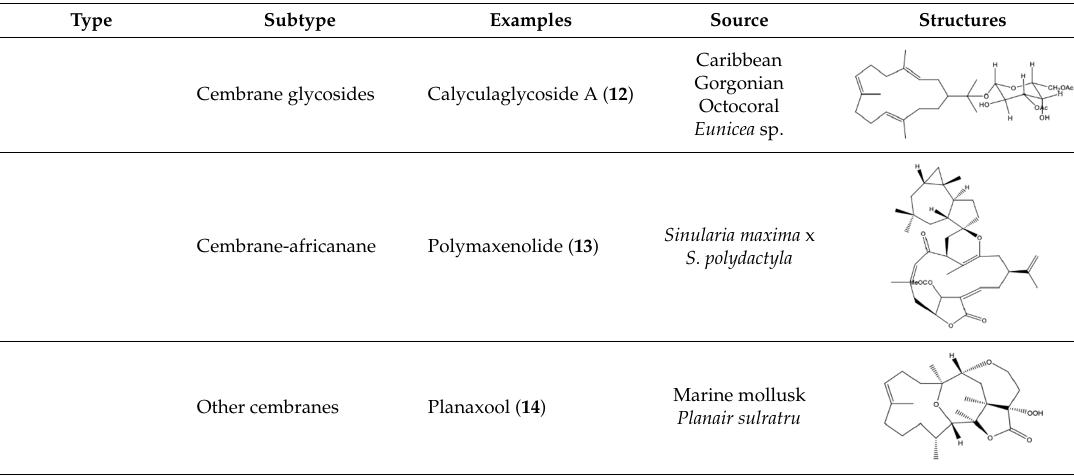
FTIR (Fourier-transform infrared spectrosocopy), single crystal X-ray diffraction, and LC-MS-IT-TOF (liquid chromatography–mass spectrometry-ion trap-time-of-flight) [9,20–57]. The review upon the source, chemistry and bioactivities of new cembrane diterpenes from marine organisms, since 2016 (27 works) (Tables 2–4) revealed that the most important sources of cembrane derivatives found in that period were coming from the genus Sarcophyton (14 works), Sinalarina (8 works) and Lobophytum (5 works). There is still one work in which the authors did not isolate new cembrane compounds but they checked the biological properties of the crude methanolic extract of Lobophytum crassum from the coast of Madagascar [24]. In other work, Al-Footy et al. [52] reported that among diverse secondary metabolites isolated from the soft coral Lobophytum sp. collected off the Red Sea Coast, in Jeddah, Saudi Arabia, only the known cembrane diterpenoid (cembrene A) had an antibacterial activity against several Gram-positive and Gram-negative microorganisms. For this reason, the brief review aims at identifying the new compounds found in those species belonging to these genera, during that